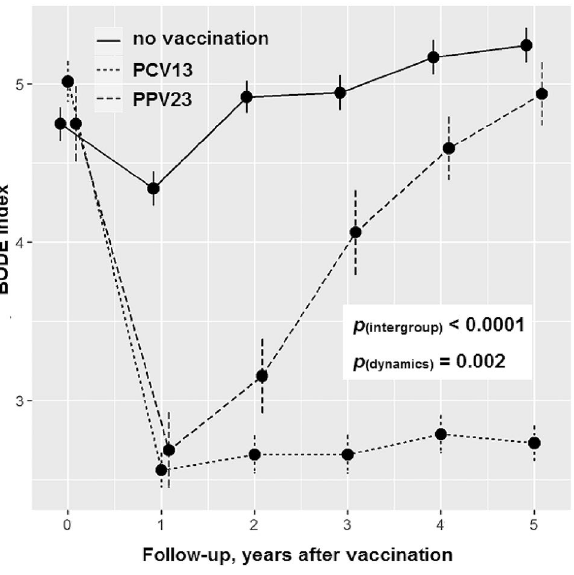
Figure 4. Dynamics of BODE index in study groups during follow-up period. The p value shows ANOVA statistics between groups.